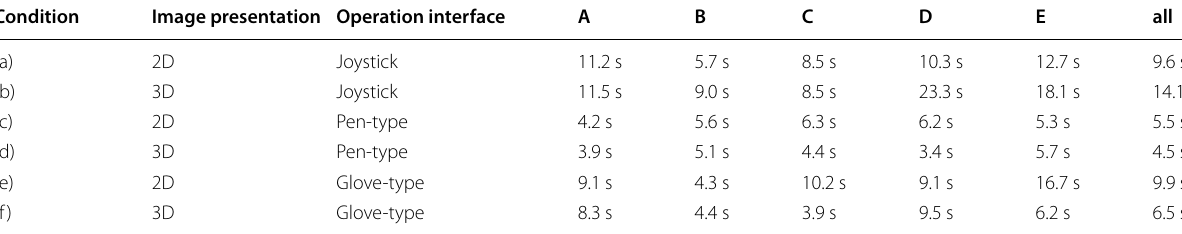
Table 6 Mean time to complete a task Condition